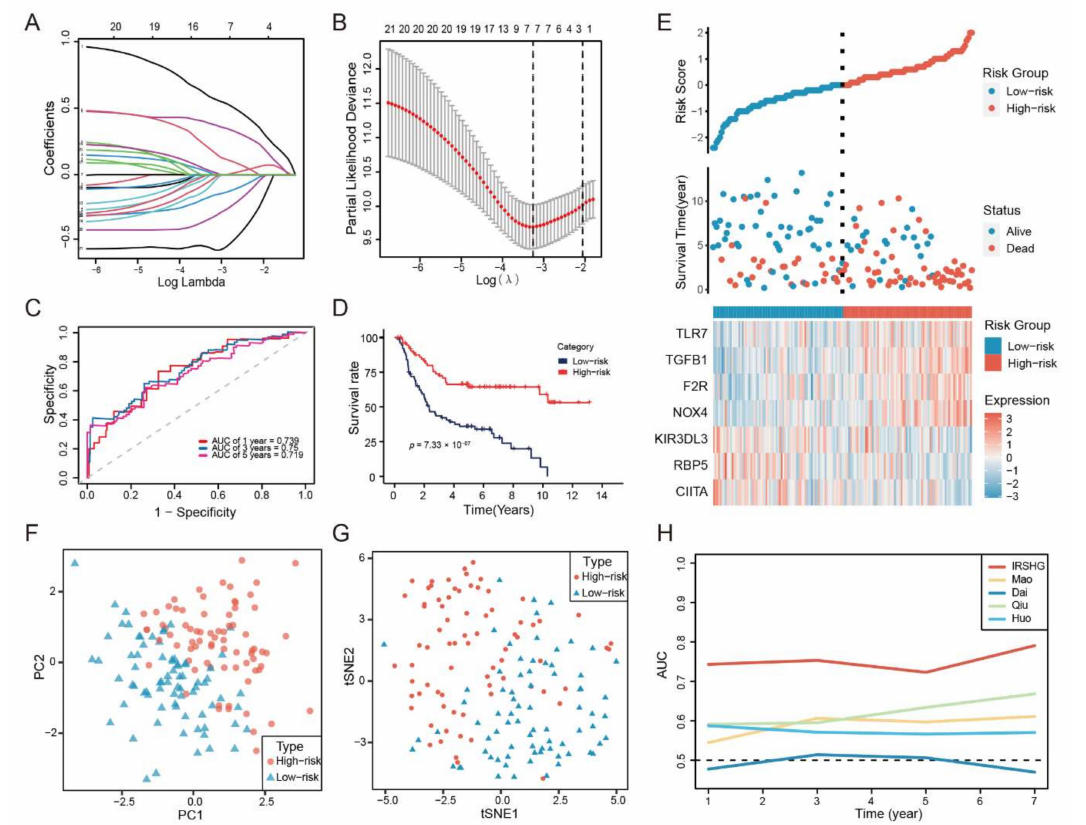
Figure 3. Construction of IRSHG and predictive power evaluation. ( A ) LASSO coefficients produced by LASSO regression analysis. ( B ) Lasso coefficient profiles of seven IRGs ( C ) ROC curve of 1-, 3-, and 5-year survival for the total set. ( D ) Kaplan–Meier survival curve for the total set. ( E ) Risk score plot showing the risk score distribution, survival status, and the expression of seven IRGs that made up IRSHG. PCA analysis ( F ) and t-SNE analysis ( G ) were performed on the high-risk group and the low-risk group based on the seven IRGs in IRSHG. ( H ) Time-dependent area under the ROC curve for the comparison of IRSHG with other four previously published prognostic signatures for